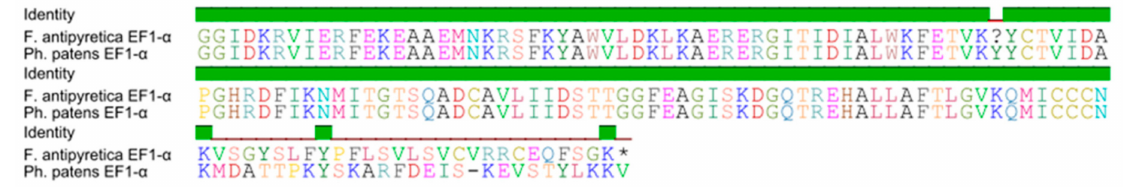
Figure 1. Deduced amino acid sequence of Fontinalis antipyretica elongation factor 1- α (EF1- α ) compared to P. patens EF1- α .